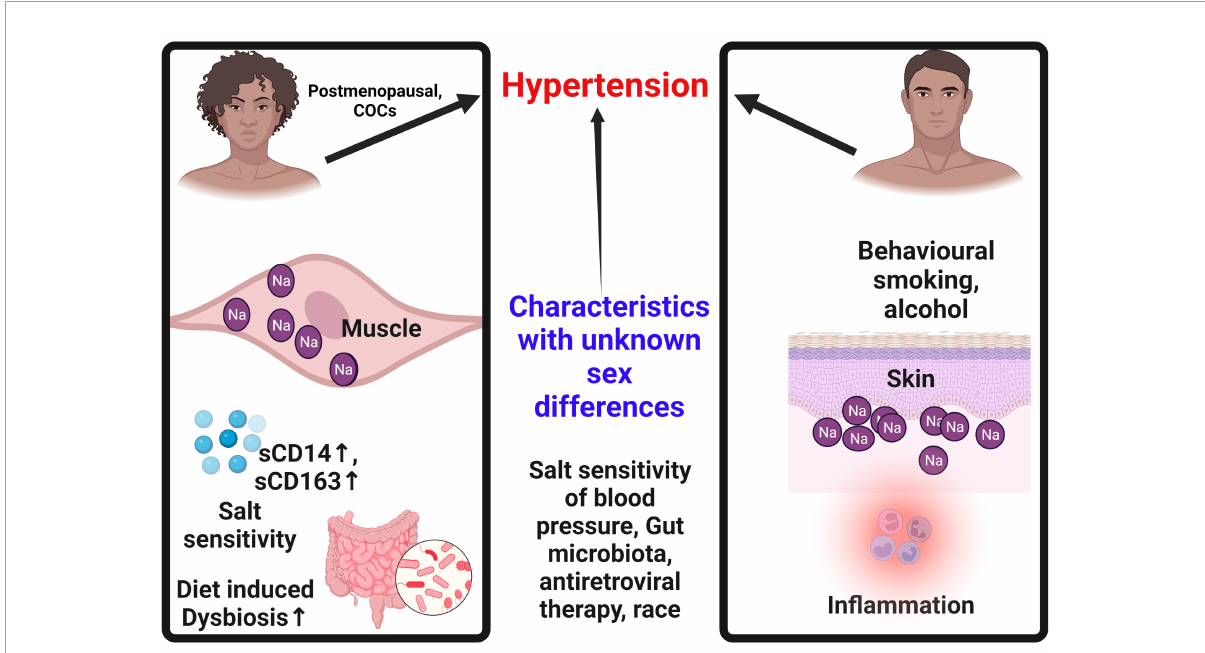
FIGURE4 Sex differences contributing to hypertension. Sex specific characteristics contribute to hypertension. In females, hypertension is only common after menopause. Females tend to store more sodium in the muscle than in the skin, a concept that may be protective when compared to males. Males on the other hand tend to store more sodium in the skin eliciting an inflammatory cascade that contributes to hypertension. Females are more susceptible to salt sensitivity and diet induced dysbiosis that contribute to hypertension. Use of combined oral contraceptives is a predictor of hypertension in females. Some behavioral patterns common in men such as alcohol and smoking increase the risk of hypertension in males. COCs, combined oral contraceptives; Na, sodium; sCD14, soluble cluster of differentiation 14; sCD163, soluble cluster of differentiation